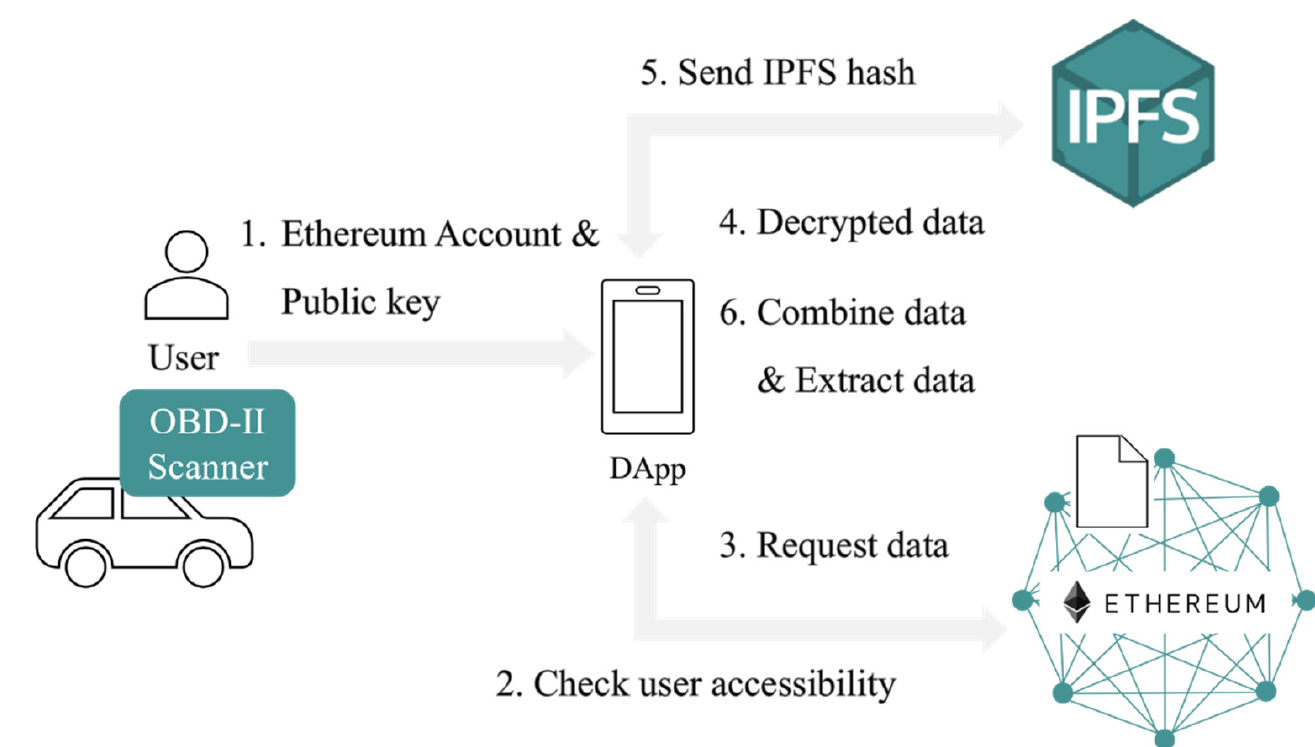
Figure 4. Process of accessing data.